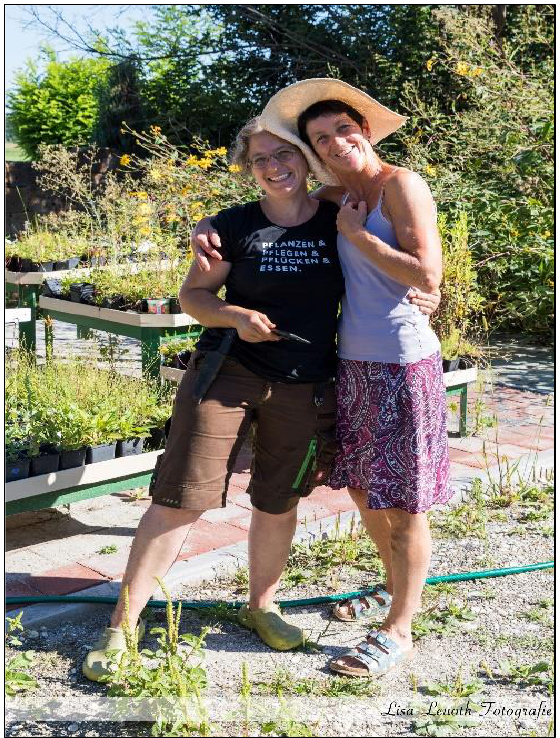
Figure 7. Hannelore Zech (left) with her